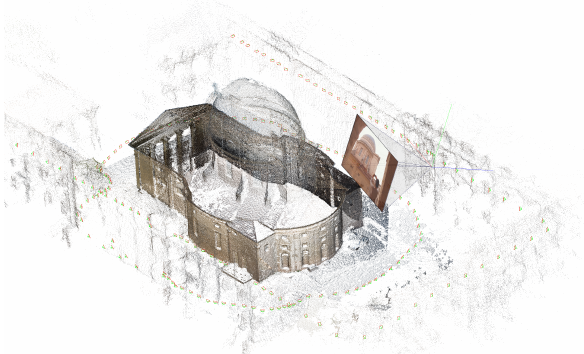
Figure 5: Isolated single picture registration using Spatial Resec- tion on Building dataset